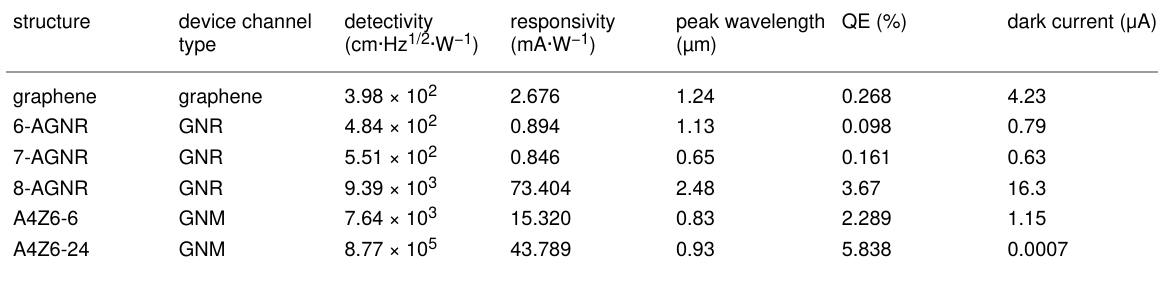
Table 2: Optical properties of different graphene-based structures at 0.3 V bias voltage.